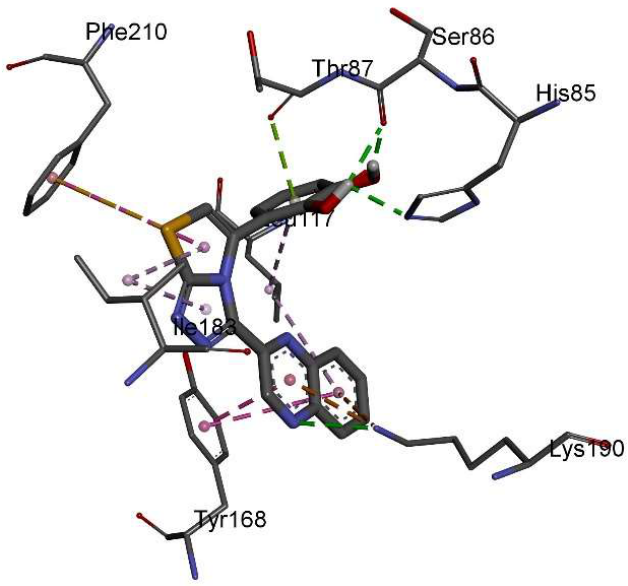
Figure 6. 3D closest interactions between active site residues of thymidine phosphorylase and synthesized compounds 14 , 16 , and 25 .